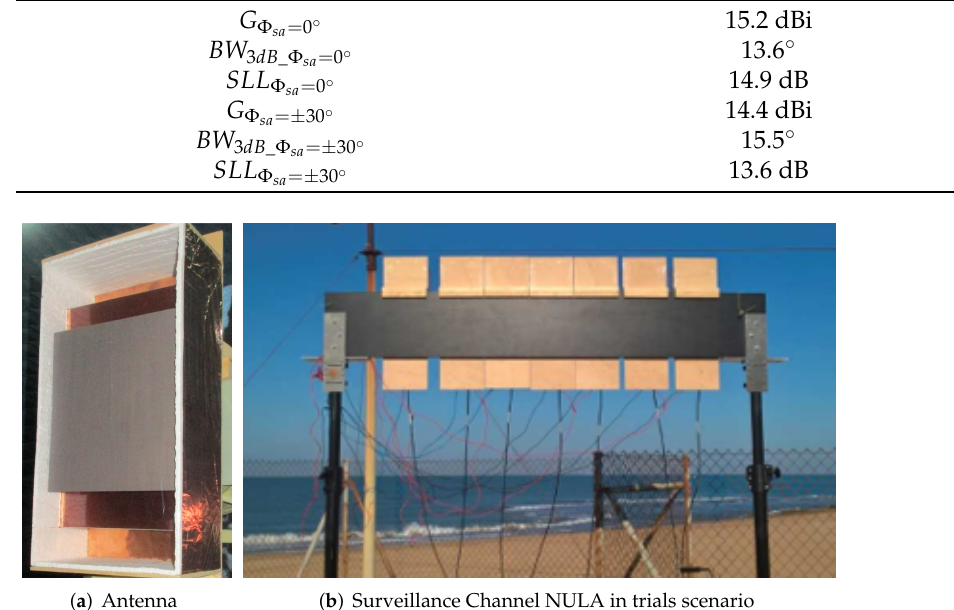
and G Φ are the array sa = 0 ◦ sa = ± 30 ◦ is the half power beamwidth sa = sa ◦ is the SideLobe Level. sa = sa ◦